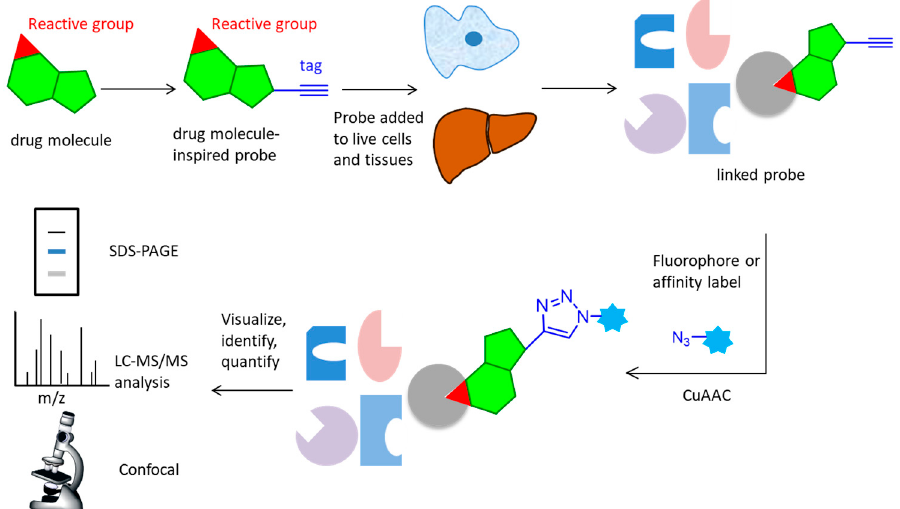
Figure 2. Overall workflow of the activity-based protein profiling approach. A probe with an active group and an alkynyl tag reacts with the active site of target protein in live cells and tissues, then undergoes CuAAC reaction with an azide containing fluorophore or affinity label. After lysis and separation, the probe is fluorescently scanned in SDS-PAGE display, LC-MS/MS analysis, or confocal imaging for identification or quantification.